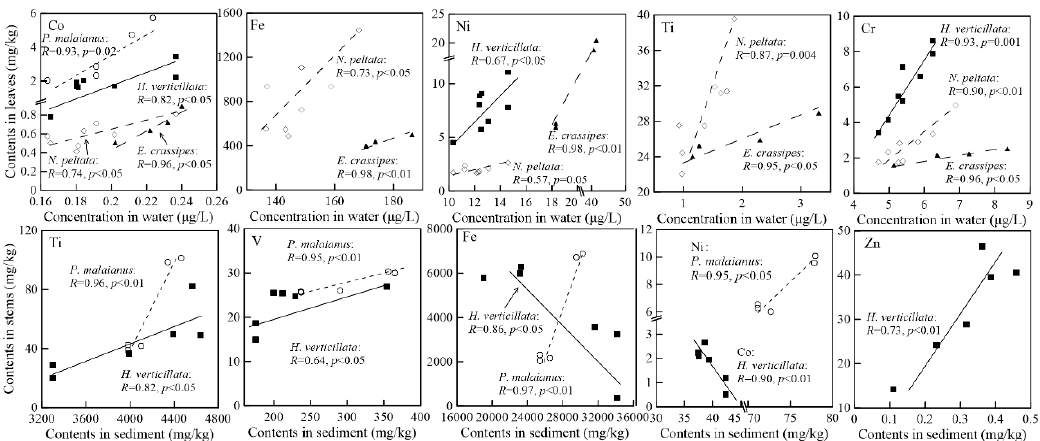
Figure 5. Correlations between heavy metals in water, sediment, and stems and leaves in plants. Pearson correlations are provided as lines and dashed lines. R and p values are also noted.